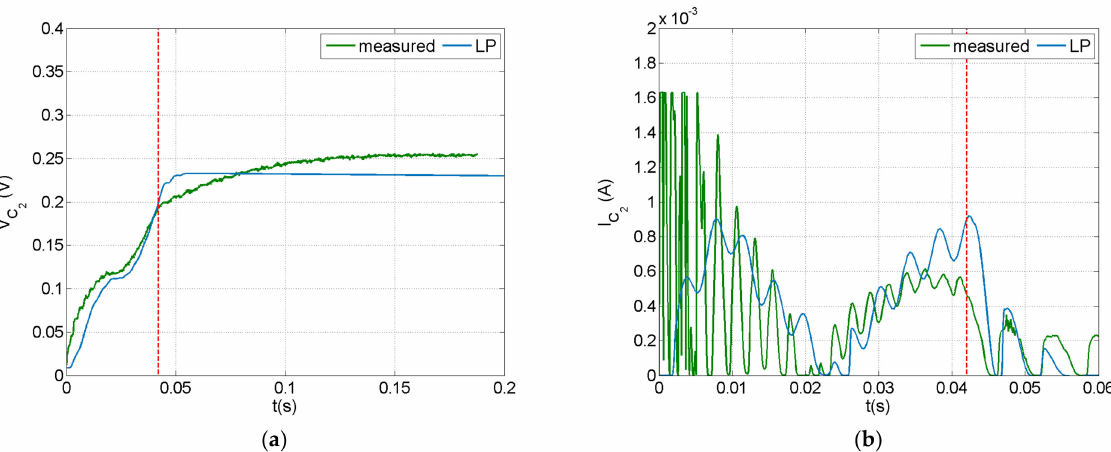
Figure 10. Predicted and measured signals at the capacitor of the PEH circuit with a 100 µ F capacitor in the case of impact: ( a ) voltage, ( b )